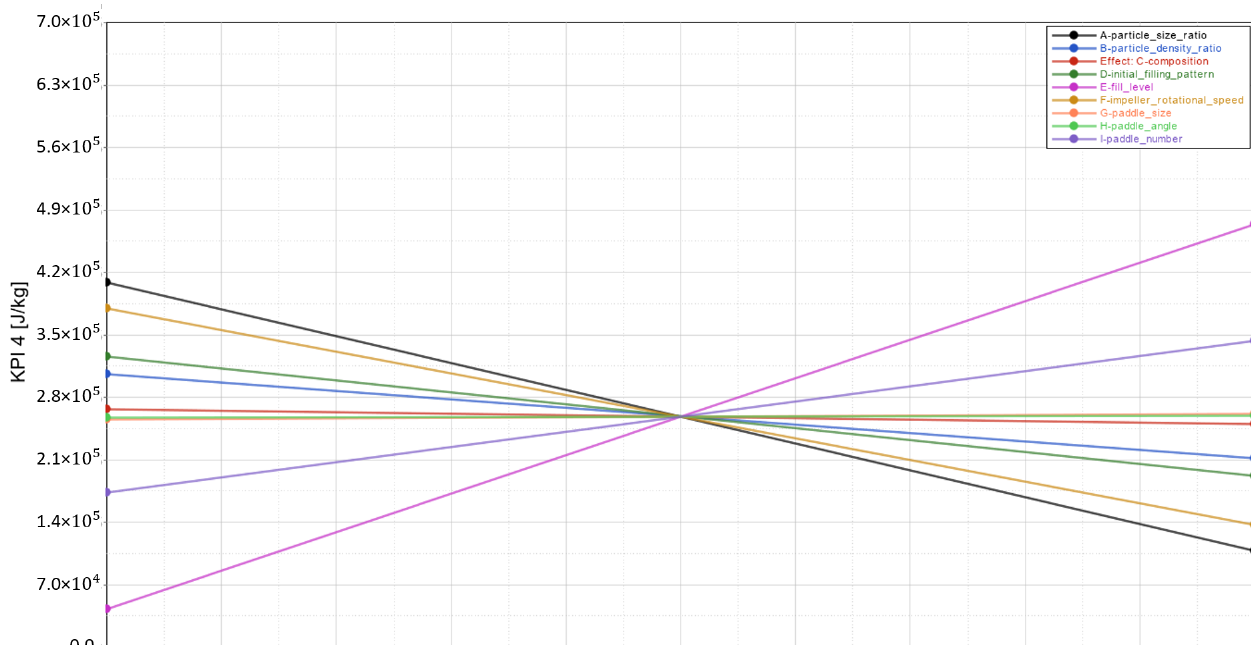
Figure 13. The main effect of factors on KPI 4 total energy consumption.